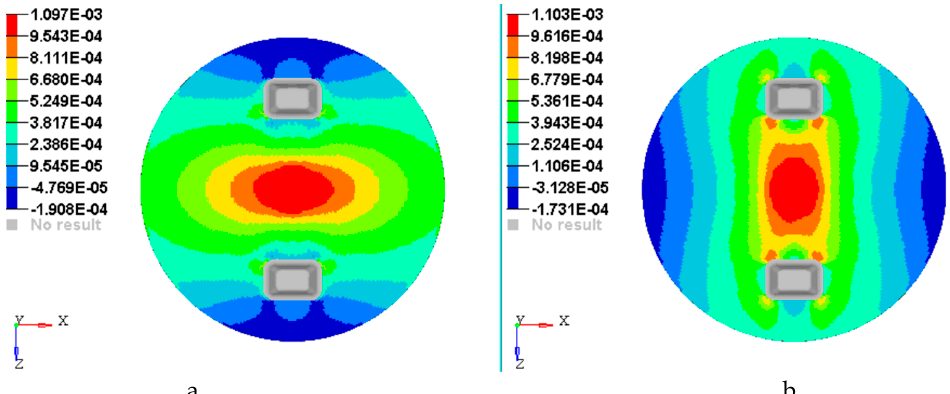
Figure 14. Plot of the strains on the bottom face of layer 1: ( a ) Strains x ε with respect to Ox axis; ( b ) strains z ε with respect to Oz axis.